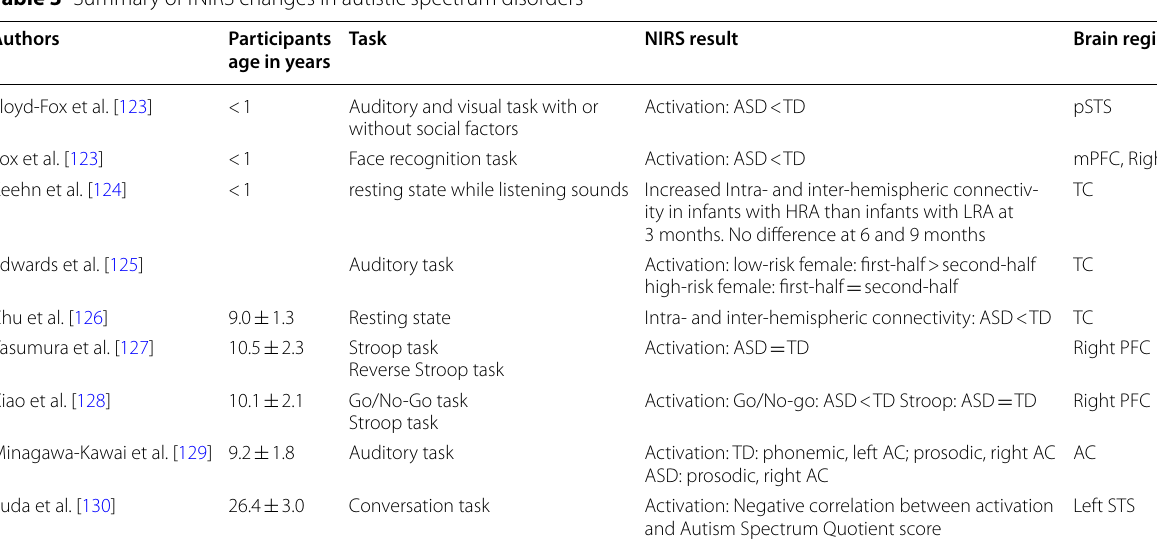
Table 3 Summary of fNIRS changes in autistic spectrum disorders